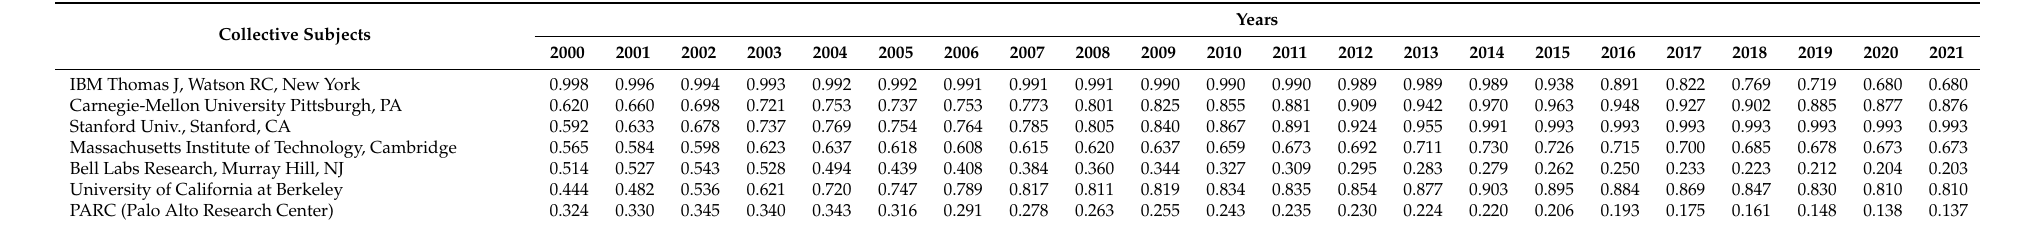
Table A3. Scientific productivity assessments of collective subjects calculated using the TWPR-CI